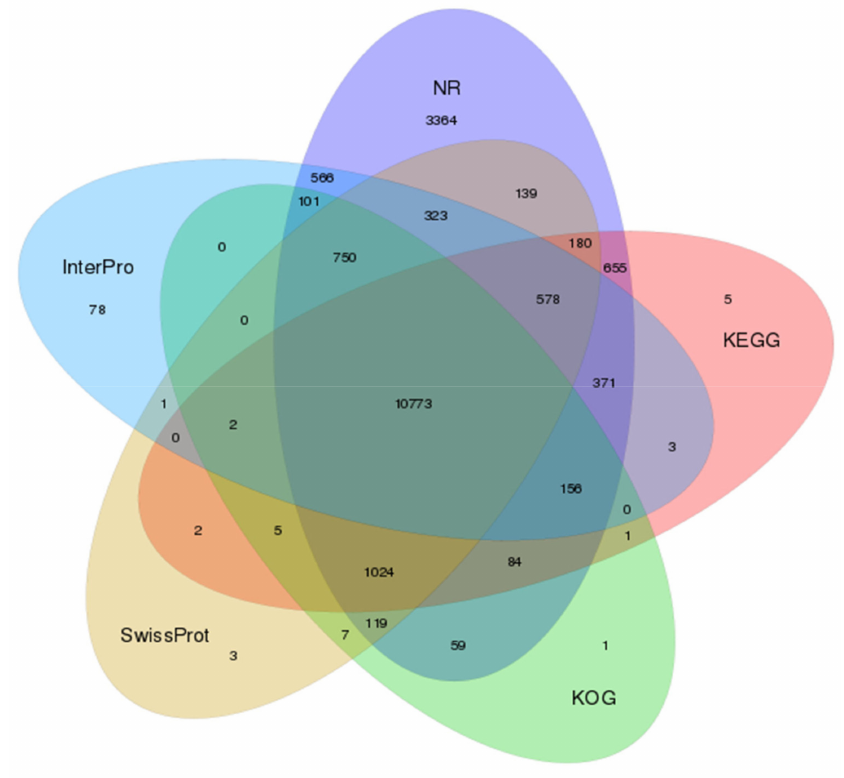
Figure 2. Venn diagram of unigenes annotated with InterPro, NR, KEGG, KOG, and SwissProt